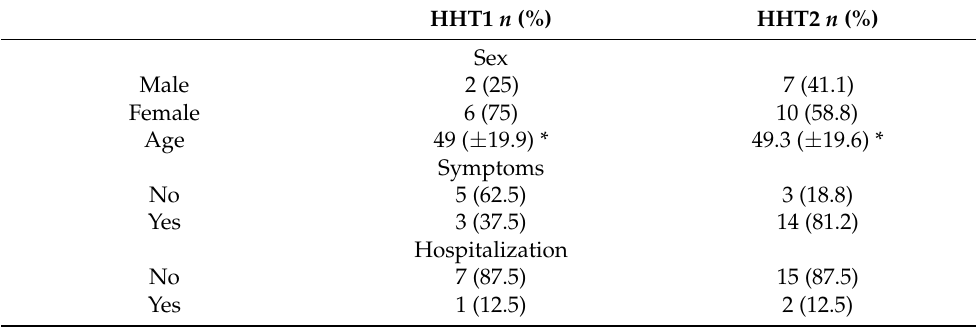
Table 2. Characteristics of patients with HHT and COVID-19. Results in percentages of the different demographic characteristics of the affected population. * Figures represent mean ( ±